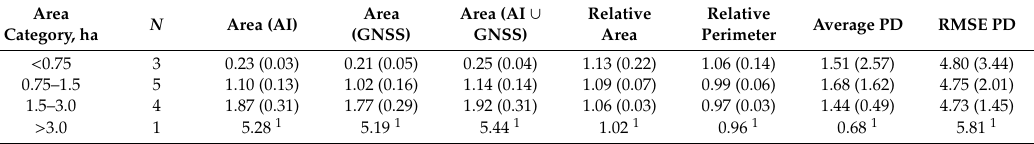
Table 4. The averaged comparison results of aerial image (AI) references to GNSS reference stands from field recordings (abbreviated as GNSS) which were kept as the reference stands. Areas are given in hectares. Abbreviations: Relative area, Area(AI) / Area(GNSS); N , number of stands; PD, perpendicular displacement of stand boundaries in meters. The standard deviations are given in parentheses.